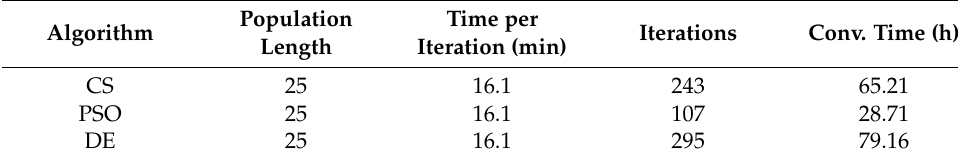
Table 7. Convergence time analysis for CS, PSO, and DE